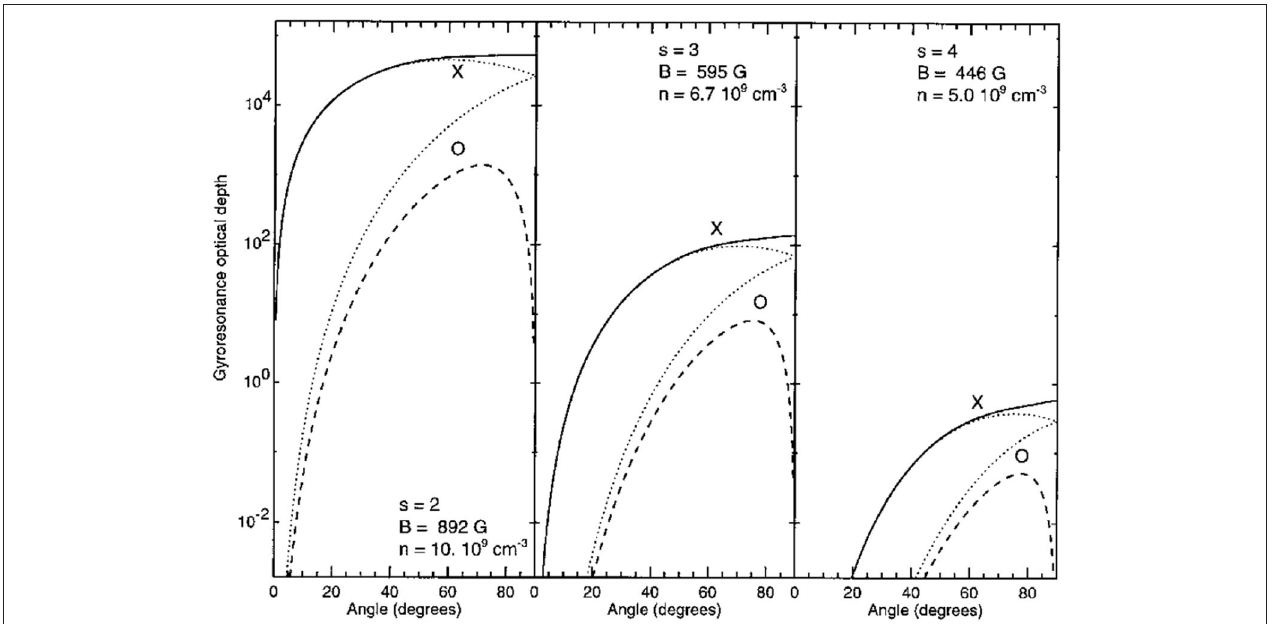
FIGURE 6 | Integrated optical depth, at 5 GHz, of the second, third, and fourth gyroresonance layers (left, middle, and right panels, respectively) as a function of the angle between the magnetic field and the line of sight. The scale height of the magnetic field is 10 9 cm, the electron temperature is 3 denoted in the figure. The solid and dashed lines correspond to x - and o -mode exact calculations, respectively. The dotted lines show x - and o -mode approximate calculations (from White and Kundu, 1997). Reproduced with permission © Springer